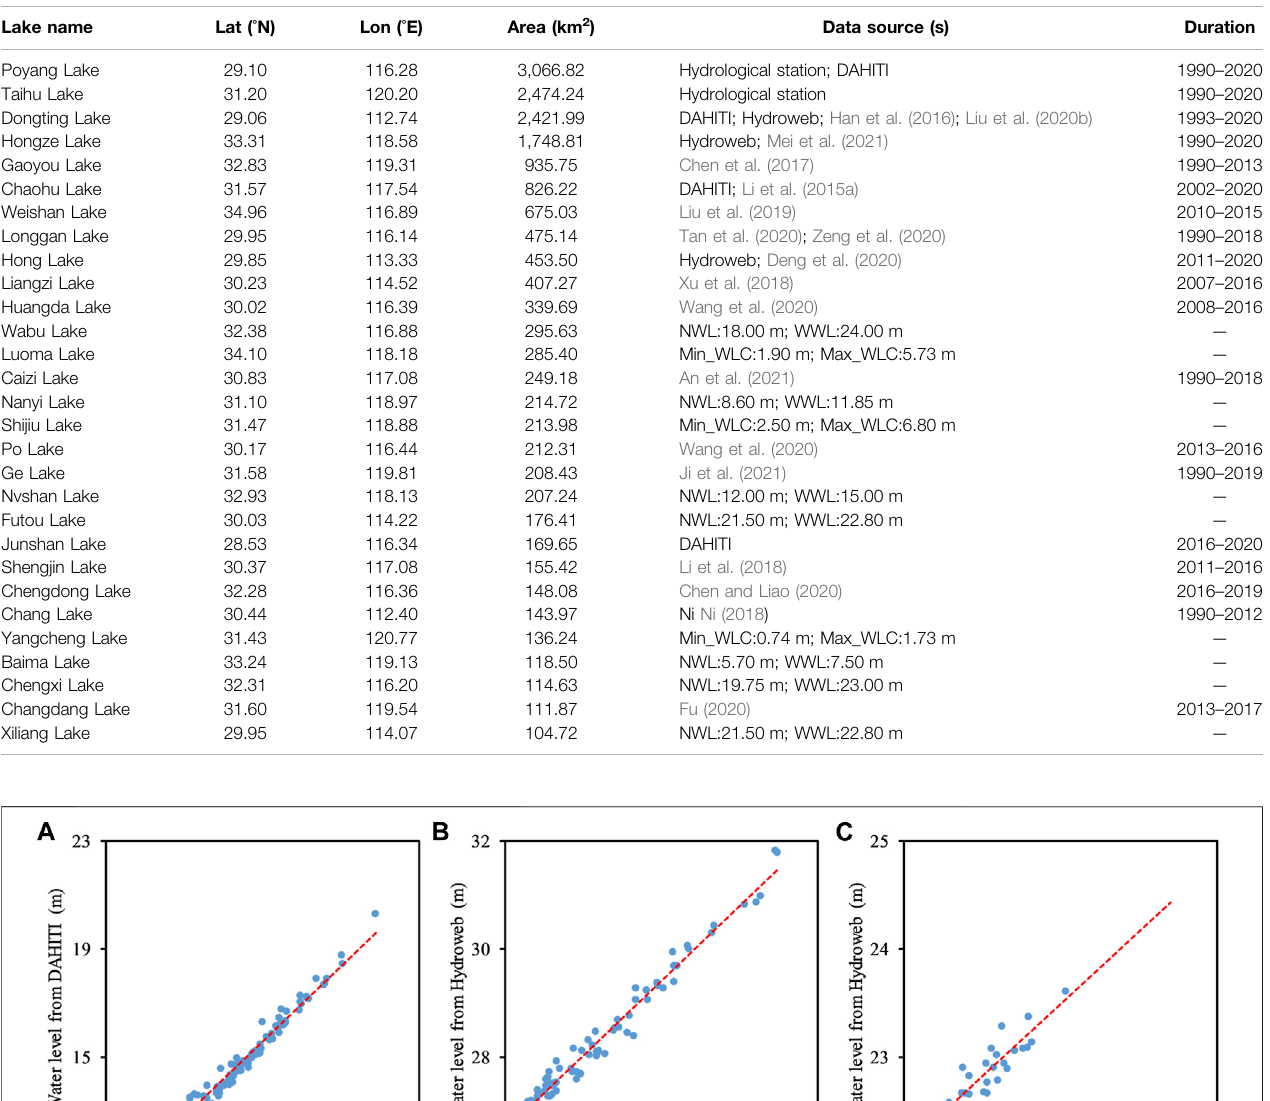
TABLE 1| Geographiclocationandwaterleveldatasourceof29lakesintheYHRB(rank lakesbylakewaterarea,NWL indicatesthenormalwaterlevel,WWLindicatesthe warning water level, Min_WLC indicates the annual minimum water level change, and Max_WLC indicates the maximum water level change).